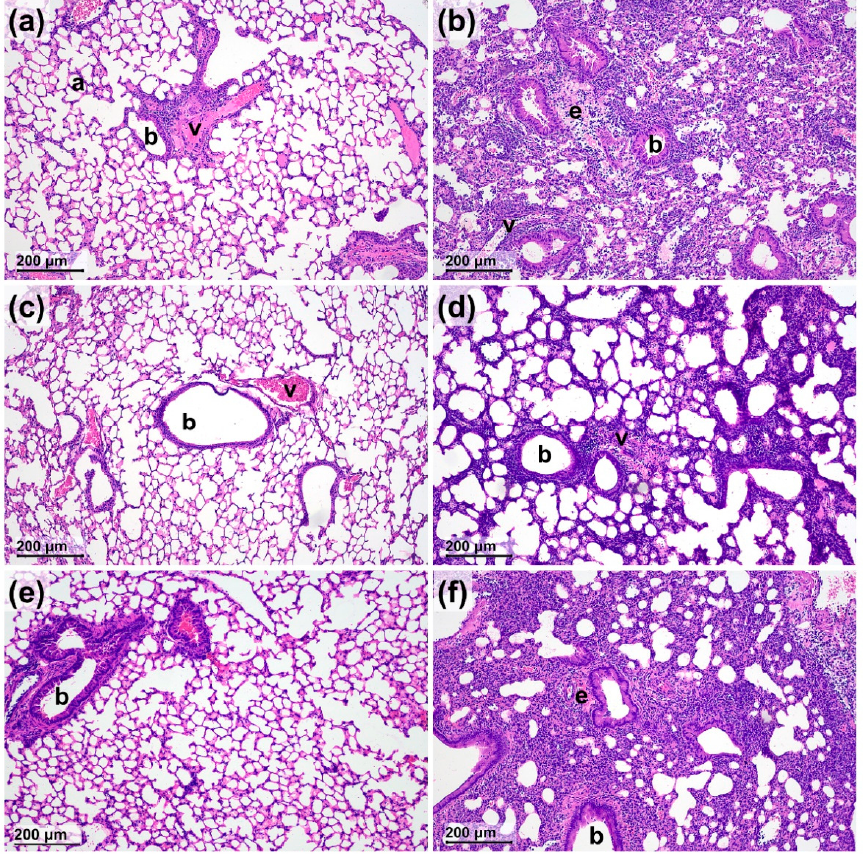
Figure 2. Representative histopathological pictures of non-inflamed PBS-treated and LPS-treated inflamed lung parenchyma of mice after Scots pine (SO) and clove oil (CO) inhalation in comparison with the control paraffin oil (PO). ( a ) PBS and PO treatment, ( b ) LPS and PO treatment, ( c ) PBS and SO treatment, ( d ) LPS and SO treatment, ( e ) PBS and CO treatment, and ( f ) LPS and CO treatment (hematoxylin–eosin staining, 100× magnification; a: alveolus, b: bronchiole, v: vessel, e: edema).